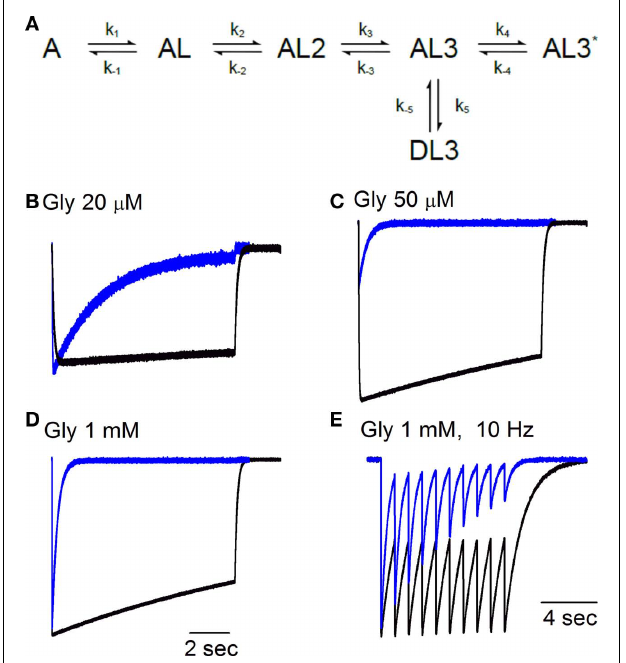
FIGUREA1 | Increase in binding and desensitization rates qualitatively reproduce 2-AG effects in model simulations (A), the frame of the model in Grewer (1999). The rate constants were adapted with increased k 4 value as explained in the text. Simulations of currents in control conditions were made with the rate constants indicated in TableA1 .The effect of 2-AG was modeled by decreasing k 3 and increasing k 1 and k 6 (see numbers in the TableA1 ). Currents are simulated as a sum of open states occupancies. (B–D) Simulated GlyR-mediated currents induced by 10s application of glycine [50 μ M (B) , 20 μ M (C) , and 1mM (D) ] in control conditions (black) and in the presence of 2-AG (blue). (E) Shows simulations of currents elicited by short (4ms) applications of 1mM of glycine in control conditions (black) and in the presence of 2-AG